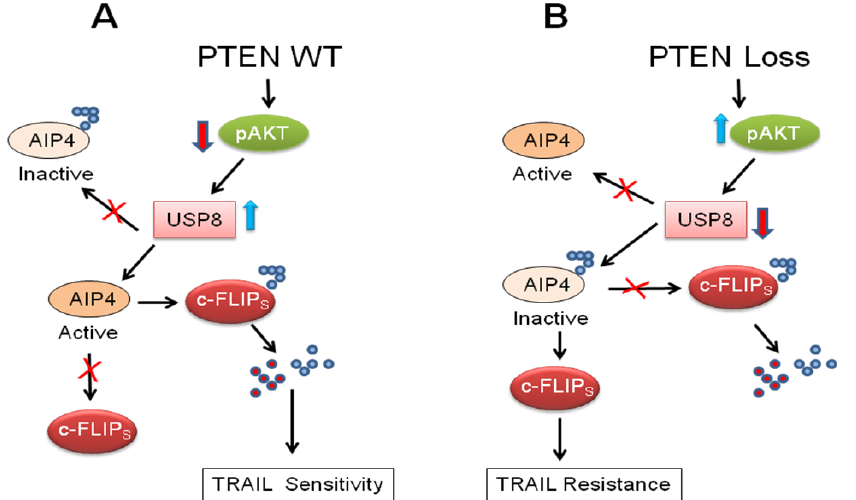
Figure 3. Schematic model of PTEN-mediated control of c-FLIP ubiquitination and TRAIL S sensitivity. ( A ). USP8 interacts with AIP4 which can ubiquitinate c-FLIP leading to its S degradation; ( B ). Increase in pAkt decreases USP8 expression, turns off the USP8/AIP4 ubiquitin switch, resulting in c-FLIP accumulation. Modified from Panner et al. S